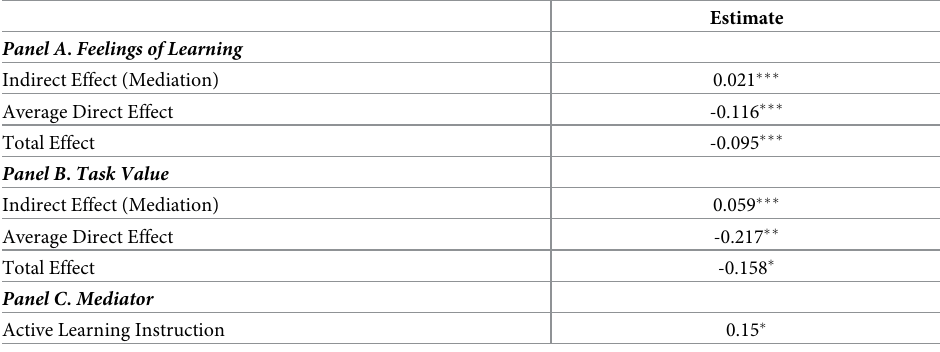
Table 3. Total, indirect (mediation), and direct effect estimates.